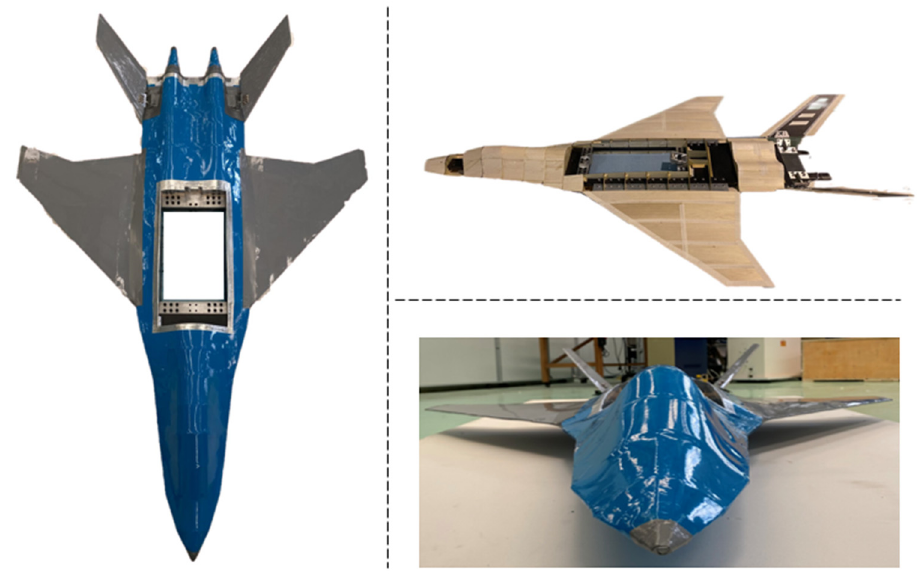
Figure 14. The final wind tunnel test aircraft model.